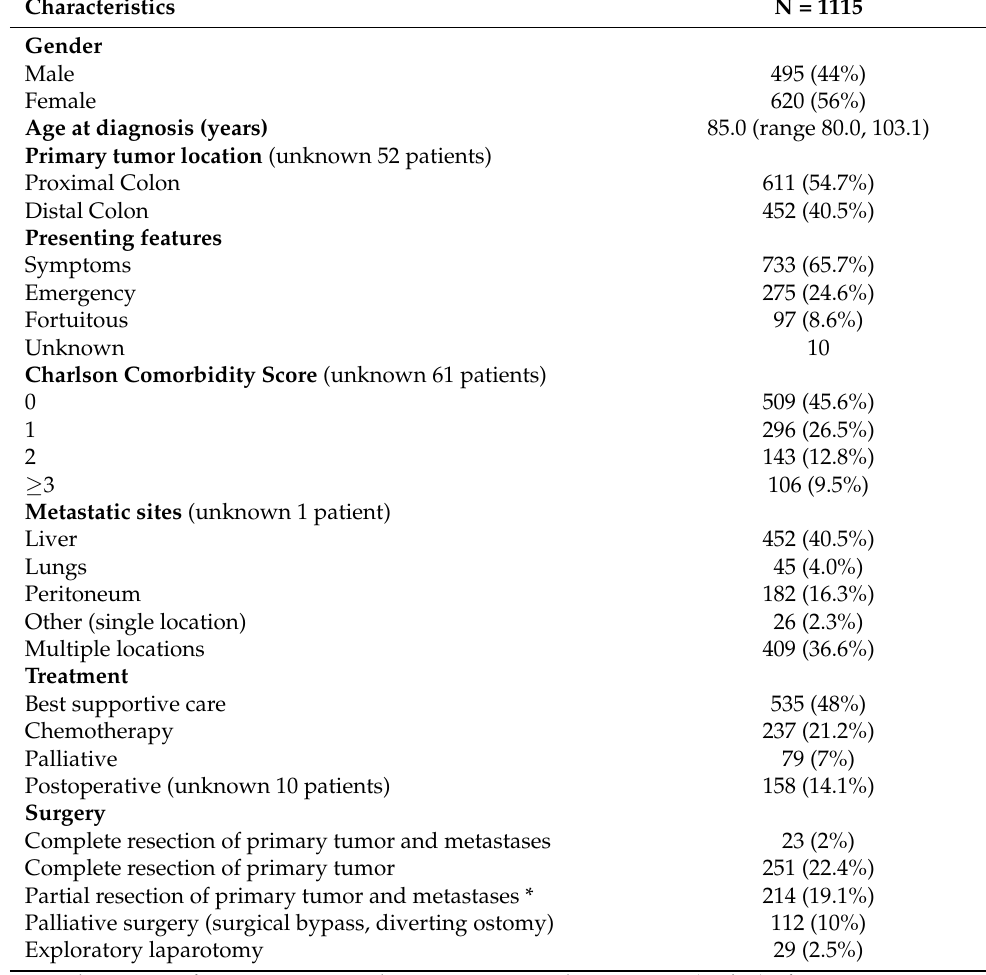
Table 1. Patient